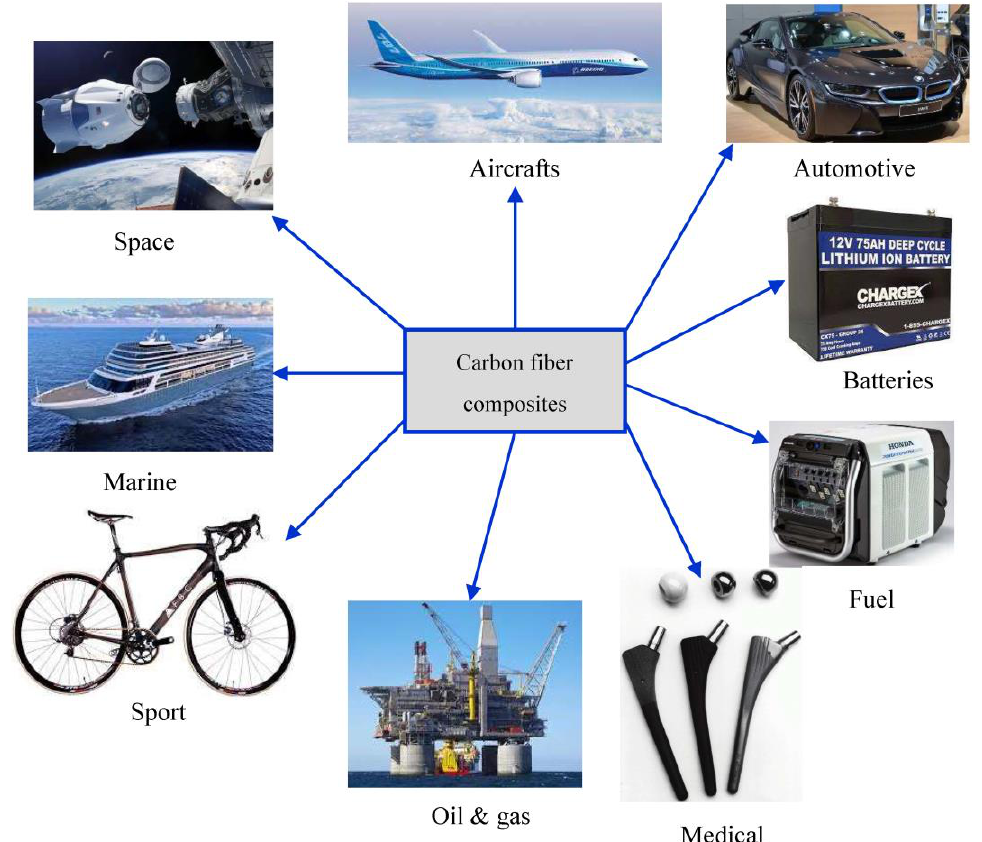
Figure 5. Various applications of carbon fibers.